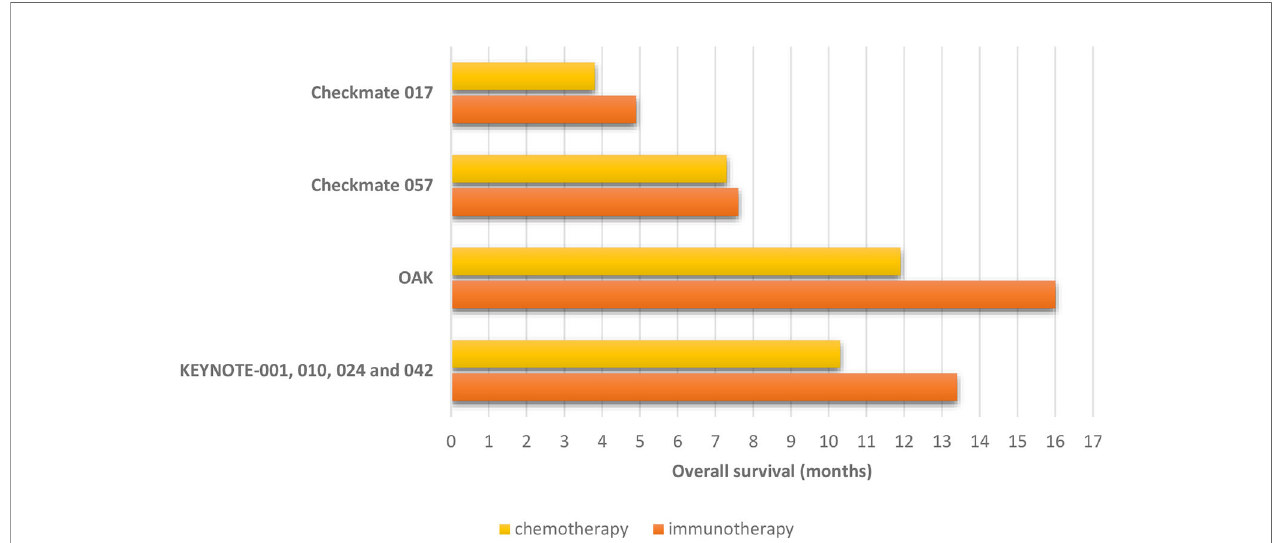
FIGURE 2 | Overall survival in non-small cell lung cancer patients with pre-treated and stable brain metastases treated in randomized trials comparing immune checkpoint inhibitors to